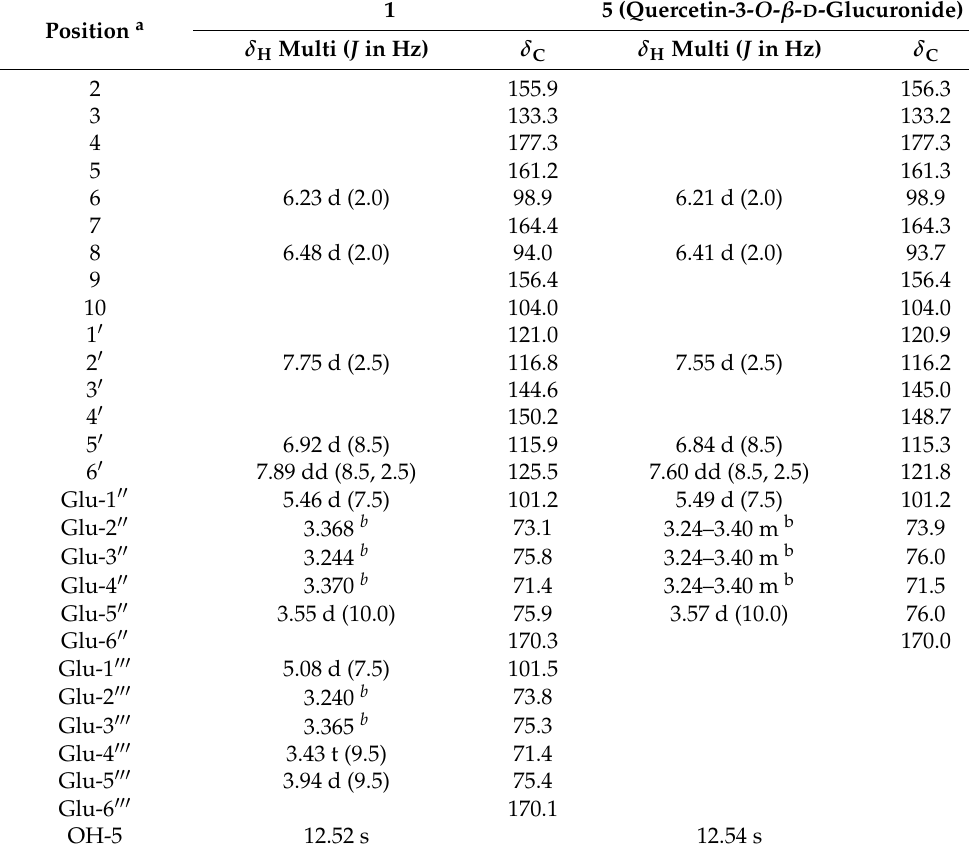
Table 1. 1 H and 13 C NMR spectroscopic data of compounds 1 and 5 ( δ in ppm, DMSO- d 6, 500 and 125